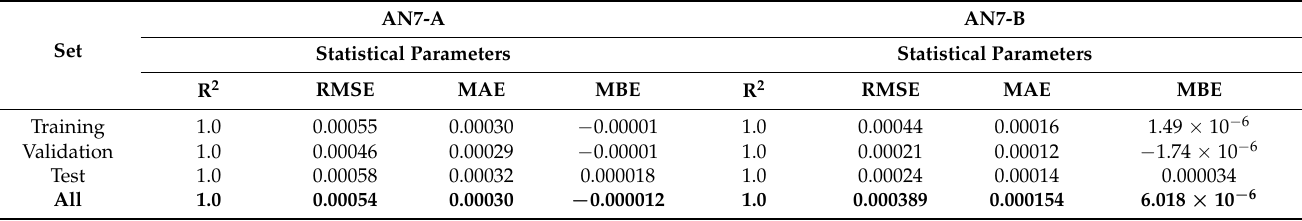
Table 6. Statistical parameters of the (A) AN7-A, (B) AN7-B